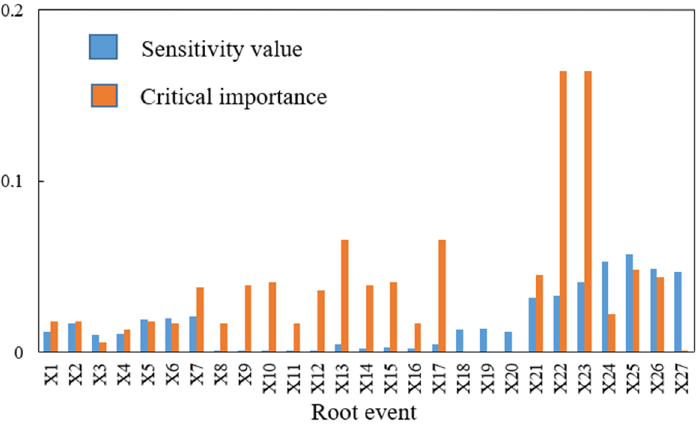
Figure 14. Comparison of sensitivity value and critical importance of the root nodes of the BN model for the coal